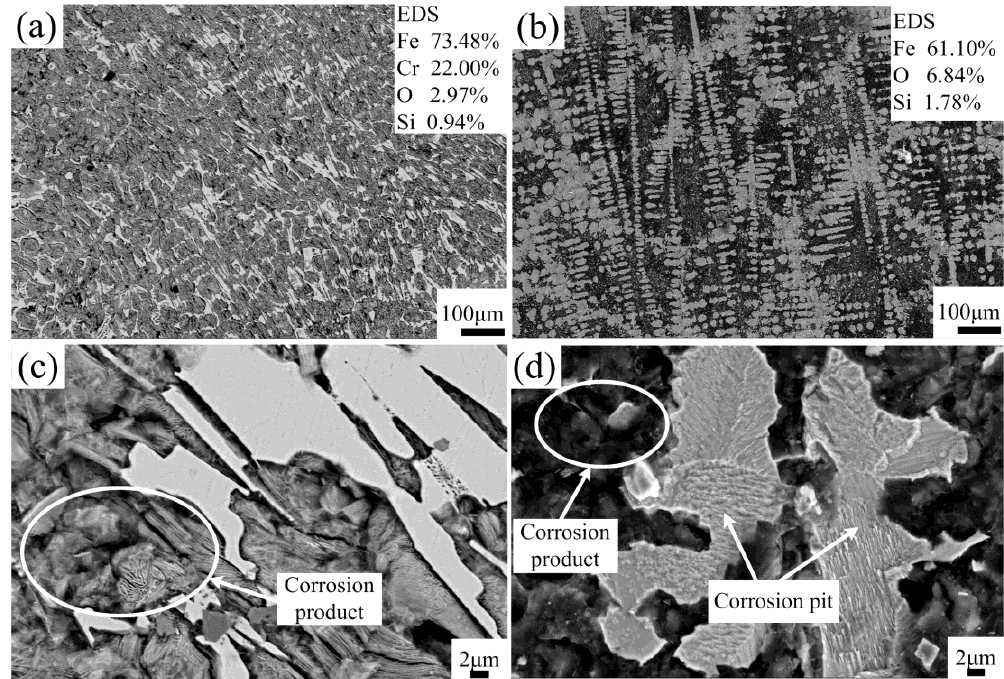
Figure 13. The SEM photographs and EDS results of the corroded surfaces in 3.5% NaCl solution: ( a ) and ( c ) are Fe-based coating and ( b , d ) are HT 300.